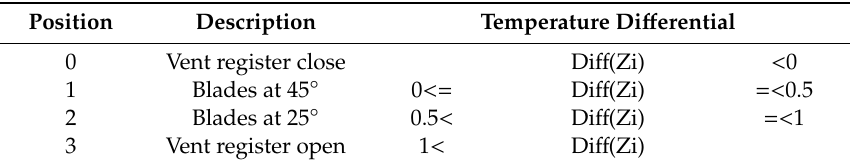
Table 4. Positions of the vent